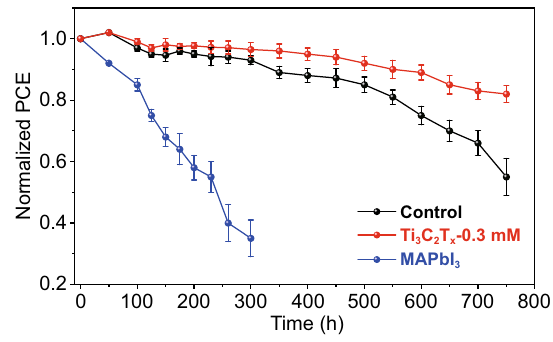
Fig. 6 Stability of MAPbI 3 ‑based, control, and Ti 3 C 2 T x ‑doping devices without sealing at air atmosphere with humidity of 55 ±